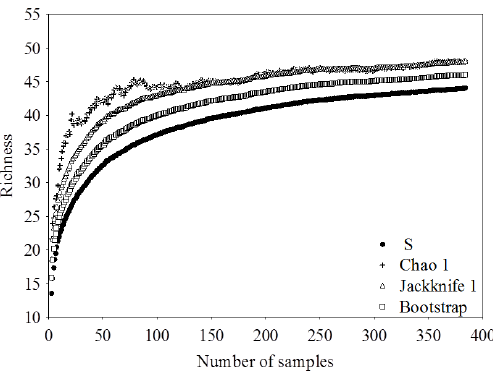
Figure 3. Accumulation curves of ostracods species resulting from different species richness estimators in the river-floodplain system of the Upper Paraná